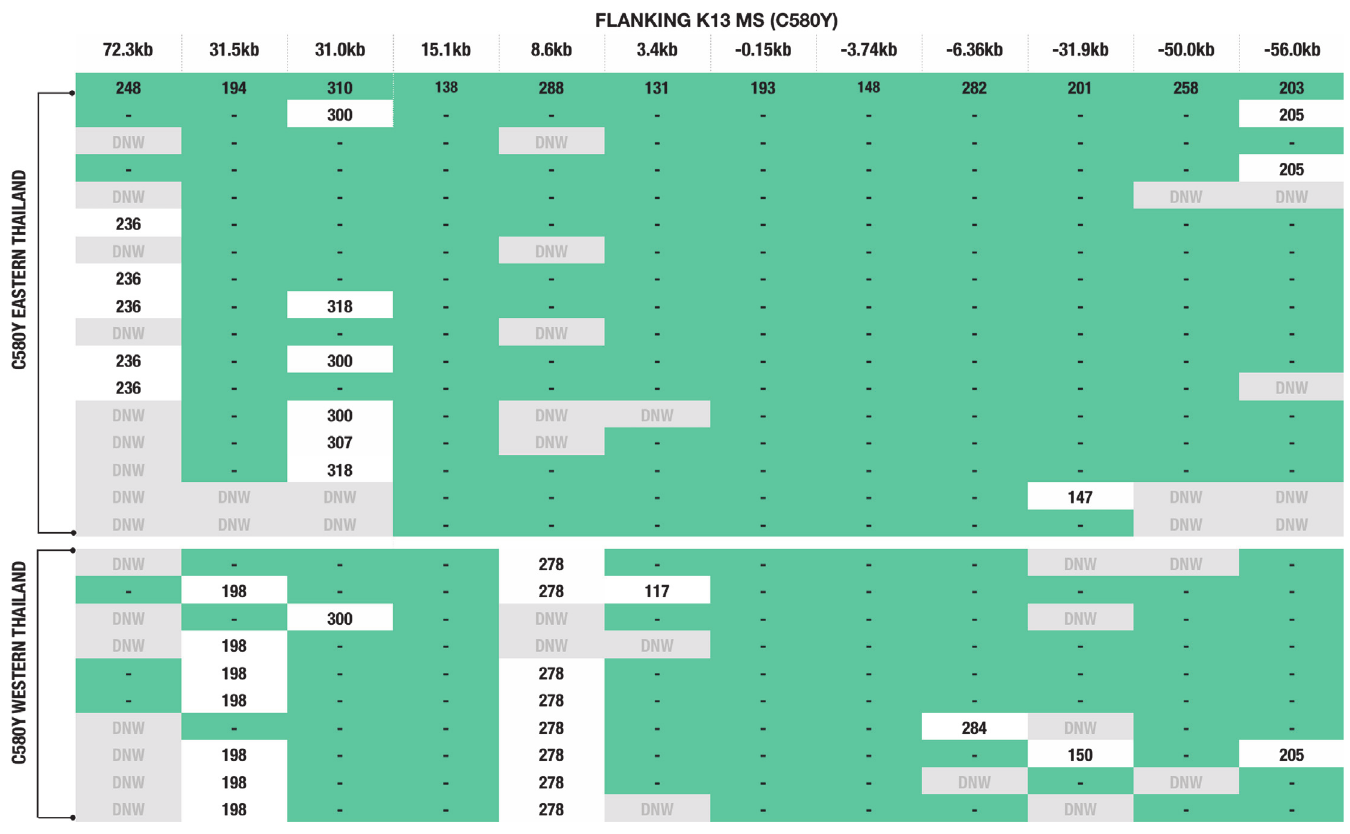
Fig 2. K13 flanking microsatellites of parasites from Thailand. The figure comprises data from 16 western and 10 eastern Thai parasites with the C580Y mutation. Allele lengths are shown for 12 microsatellites positioned at: 72.3kb, 31.5kb, 31.0kb, 15.1kb, 8.6kb, 3.4kb, -0.15kb, -3.74kb, -6.36kb, -31.9kb, -50.0kb, and -56.0kb. Teal green shading and lines indicate identical allele sizes. DNW (in grey) = indicates no successful amplification after a third attempt or not enough DNA was available to repeat the